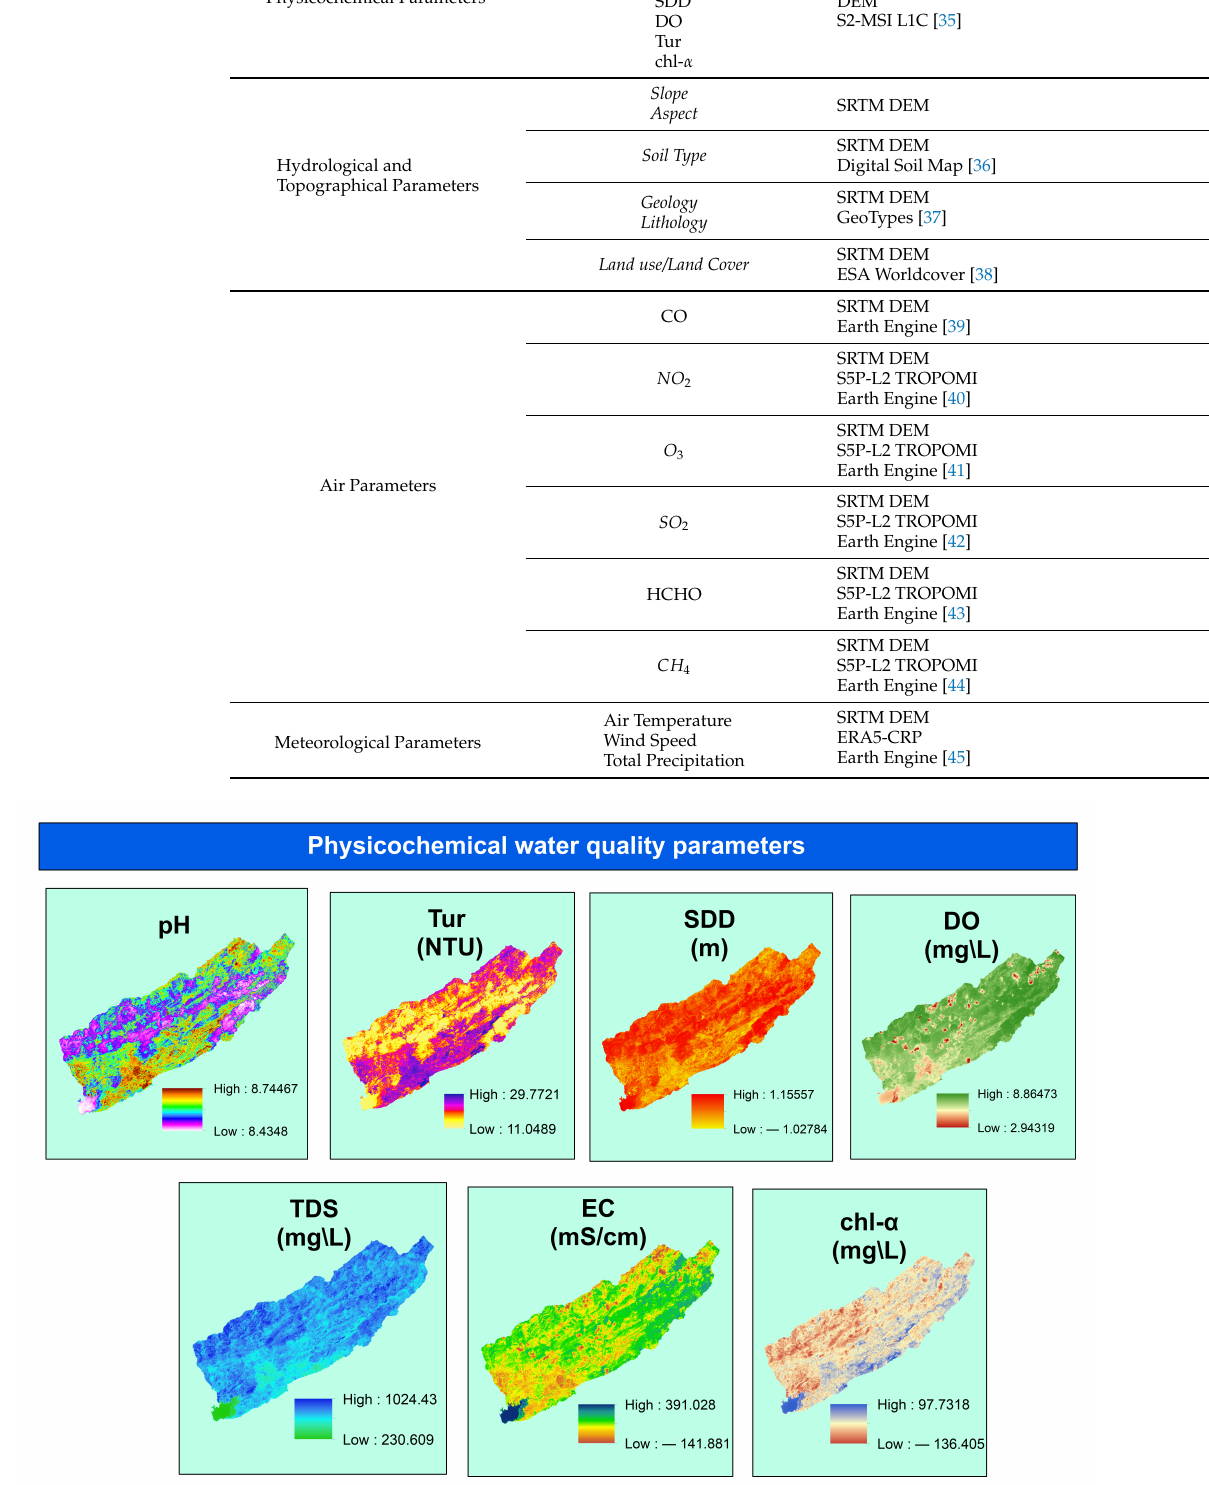
Figure 3. Physicochemical parameters for the Rawal